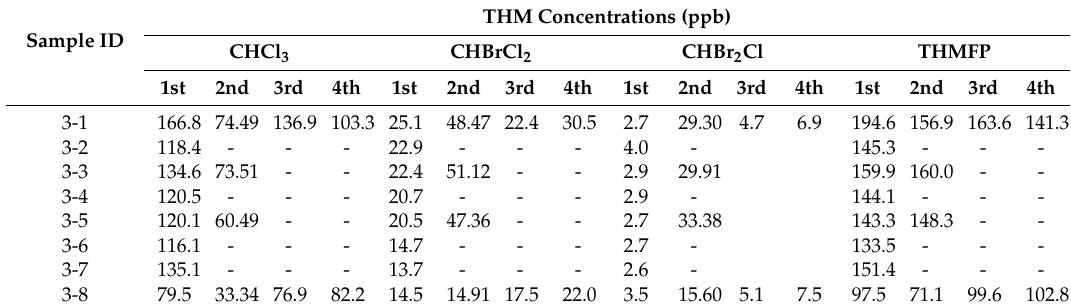
Table 7. THM formation potential and major THM species in the selected samples of System